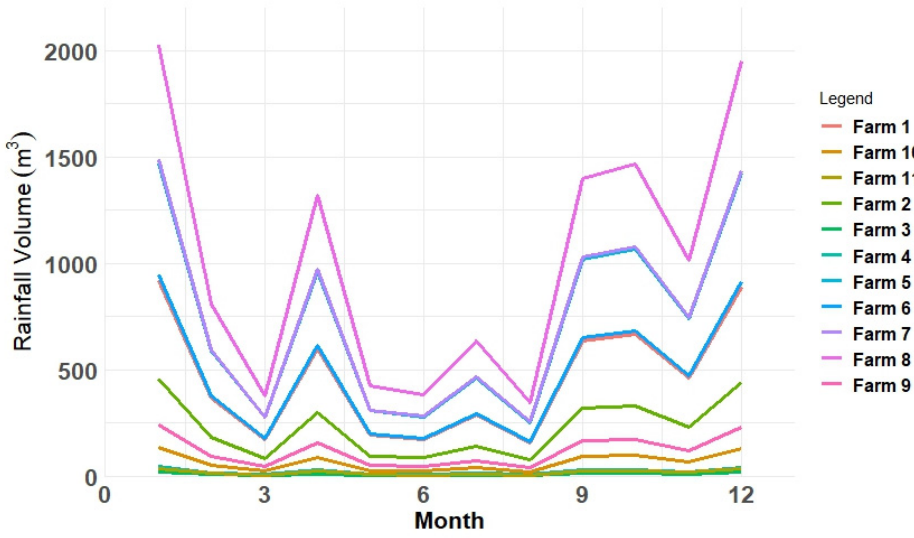
Figure 13. Monthly rainfall (m 3 ) at each urban farm for a one-year period.